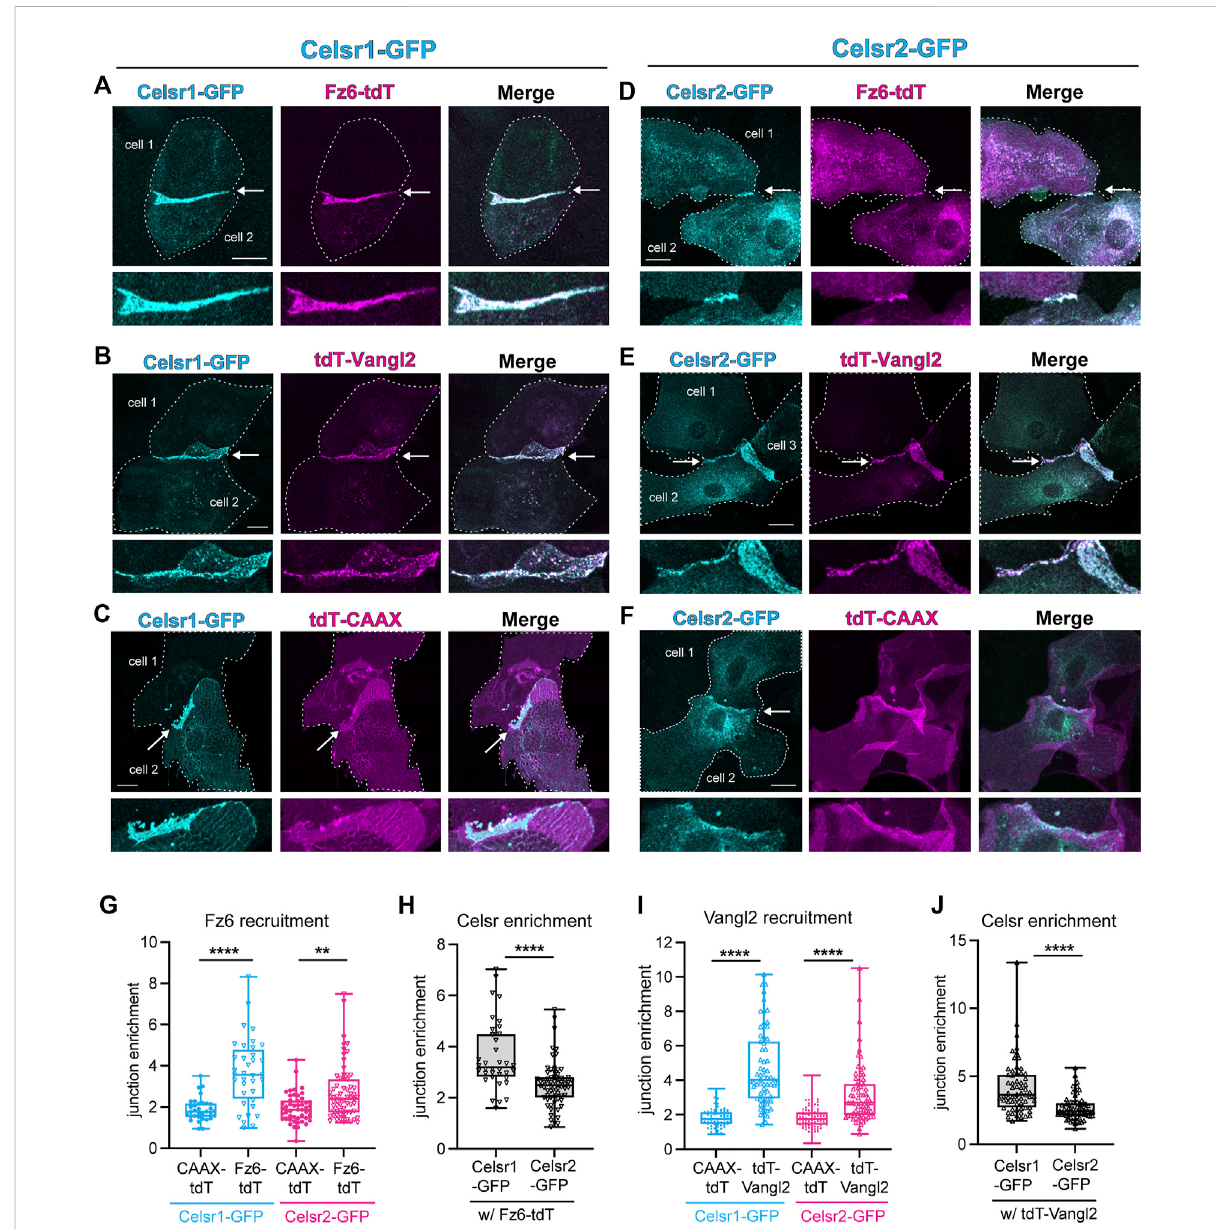
Celsr2 recruits Fz6 and Vangl2 to keratinocyte junctions, similar to Celsr1. (A – C) Representative cell pair co-expressing Celsr1-GFP and Fz6- tdTomato (A) , tdTomato-Vangl2 (B) or anon-junctional membrane markertdTomato-CAAX (C) . Arrowheadsmark the junctionbetween2 cells and amagni fi edviewofthejunctionisrepresentedbelowtherespectiveimages.Scalebars=20um. (D – F) Representativecellpairco-expressingCelsr2- GFPandFz6-tdTomato (D) ,tdTomato-Vangl2 (E) andtdTomato-CAAX (F) .Arrowheadsmarkthejunctionbetween2cellsandamagni fi edview ofthejunctionisrepresentedbelowtherespectiveimages.Scalebars=20 um. (G) BoxplotsdepictingjunctionenrichmentratiosforFz6-tdTomato compared to tdTomato-CAAX when co-expressed with Celsr1-GFPor Celsr2-GFP(n = 33 for Celsr1-tdTomato CAAX, n= 49 for Celsr2-tdTomato- CAAX, n = 36 for Celsr1-Fz6-tdTomato, n = 66 for Celsr1-Fz6-tdTomato). (H) Box plots depicting junction enrichment values of Celsr1-GFP versus Celsr2-GFP in cells co-expressing Fz6-tdTomato. (I) Box plots depicting junction enrichment ratios for tdTomato-Vangl2 compared to tdTomato- CAAX when co-expressed with Celsr1-GFP or Celsr2-GFP (n = 66- Celsr1-tdTomatoCAAX, n = 87-Celsr2 tdTomatoCAAX, n = 63-Celsr1 tdTomatoCAAX, n = 67-Celsr2-tdTomatoCAAX). (J) Box plots depicting junction enrichment of Celsr1-GFP and Celsr2-GFP in cells expressing tdTomato-Vangl2. Data pooled from two independent experiments for Fz6-tdTomato and three independent experiments for tdTomato-Vangl2. Kolmogorov-Smirnov tests, **** p < 0.0001, ** p =